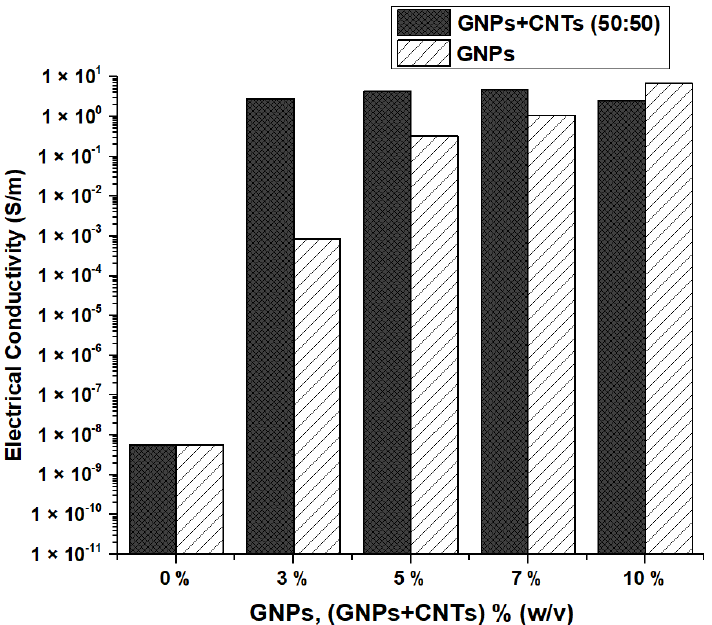
Figure 10. Comparison of electrical conductivity of cotton fabrics coated with 1 layer (GNPs + CNTs and GNPs only).